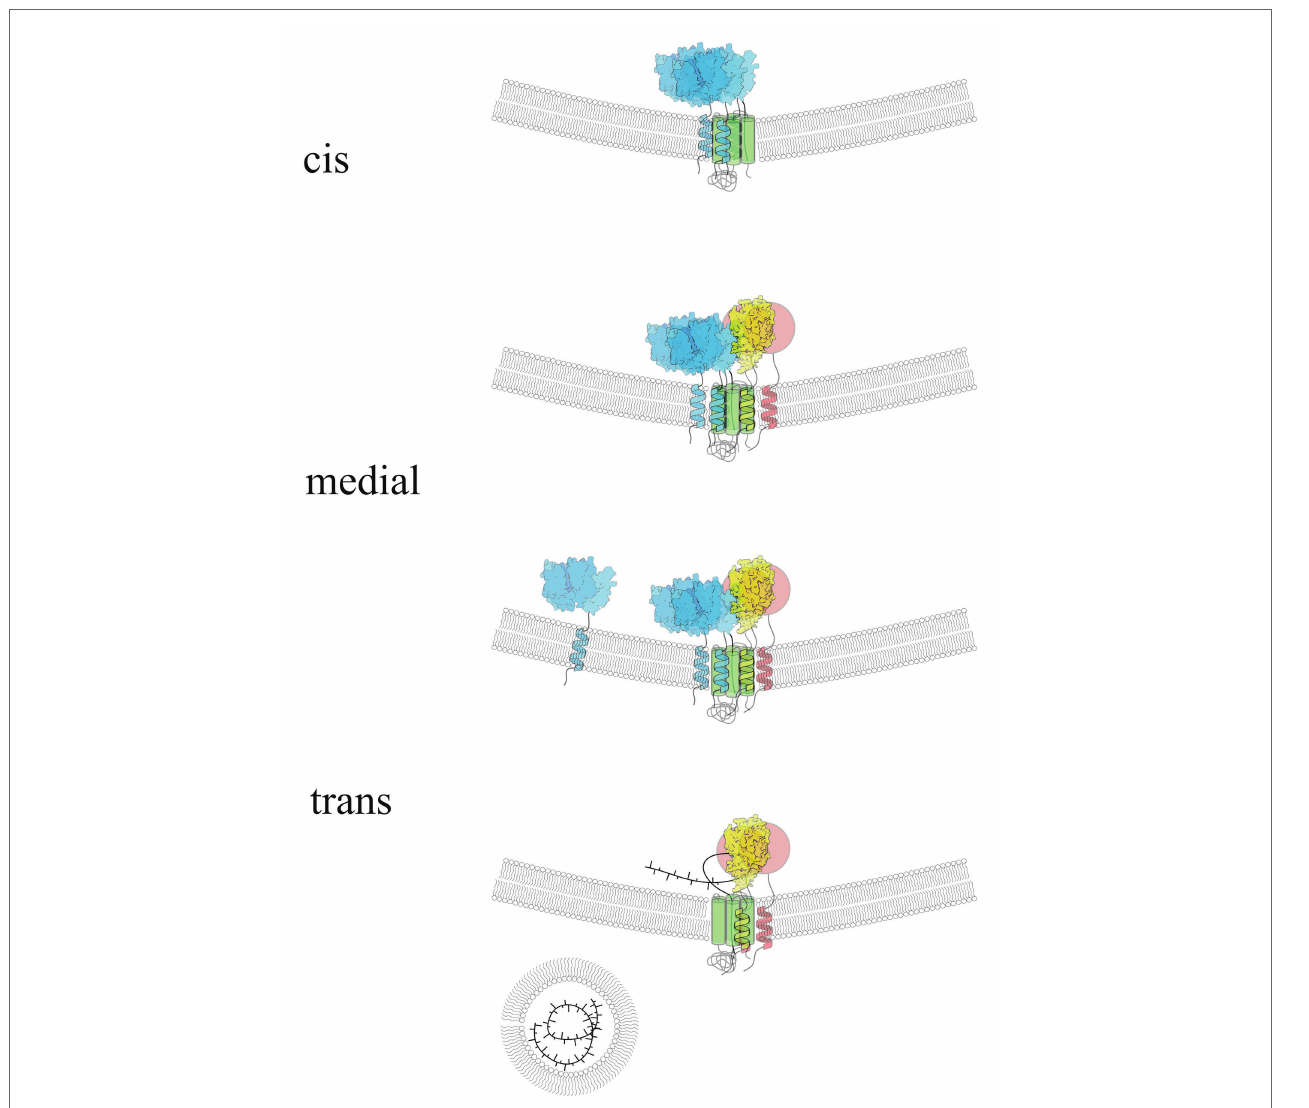
FIGURE 3 | Hypothetical presentation of xyloglucan synthesizing complex organization and its compositional dynamics in different Golgi cisternae. The colors and structural organizations are identical to those shown in Figure 2 . CSL (green) and three XXTs (blue) form the first stage of the complex to synthesize the glucan backbone and xylosylate it as the first step in xyloglucan biosynthesis. Later in Golgi maturation, the other three glycosyltransferases (GTs) are added to the complex to finish the side chain synthesis, while CSL and XXTs continue to elongate and xylosylate the backbone. Perhaps XXTs can leave the complex at the later stages of synthesis; however, the backbone continues to be attached to CSL, assisting MUR3, XLT2, and FUT1 to finalize the synthesis of complete polysaccharide structure. When the complex reaches the trans-Golgi, the polysaccharide is released via currently unknown mechanism and gets packed into transport vesicles to be delivered to the cell surface. The hypothetical distribution of xyloglucan-synthesizing GTs depicted here is based on multiple studies of protein-protein interactions among these proteins and on data from electron microscopy studies of GT localization within different Golgi